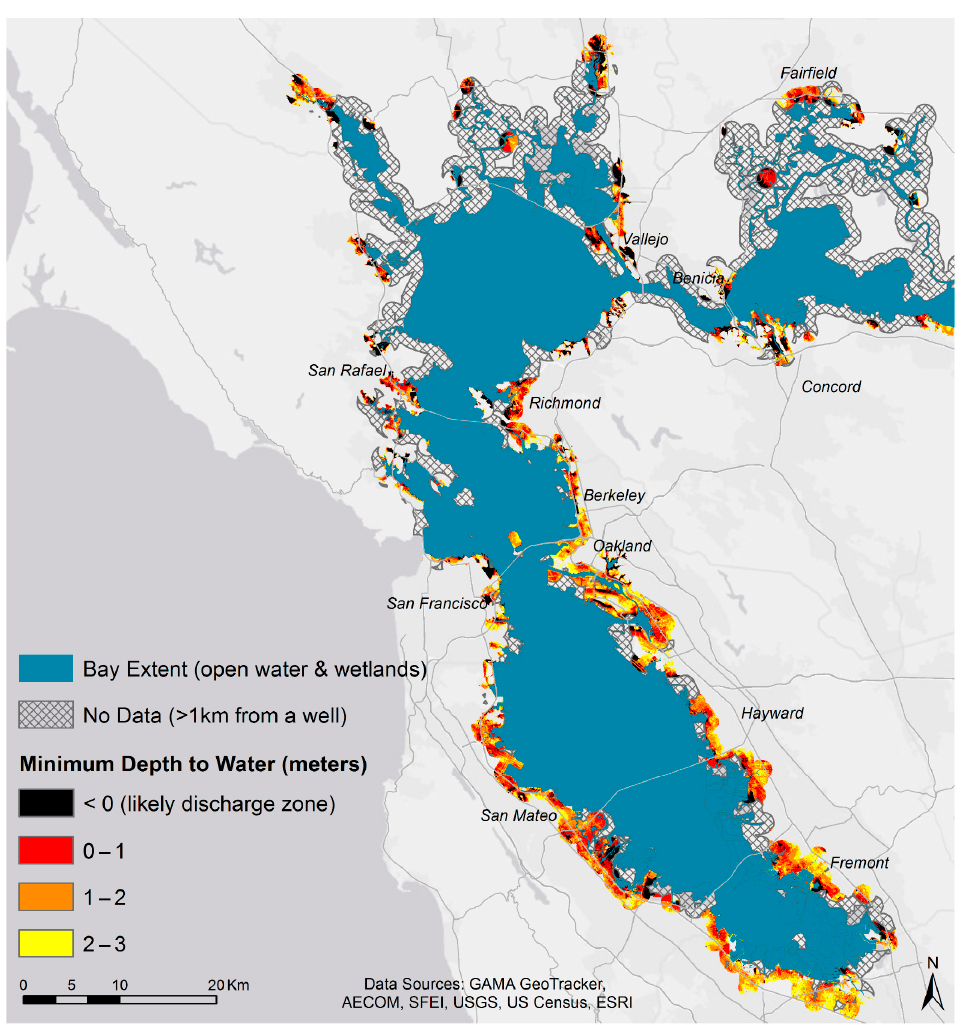
Figure 4. Minimum depth-to-water for the coastal San Francisco Bay Area. Shallow groundwater within one kilometer of the coast is shown in color, with the shallowest areas in red. Our method produced some negative values that suggested groundwater was already emergent, usually where there were no well points in the dataset at the base of a slope or in a valley. These areas (in black) most likely had very shallow groundwater with seasonal surface discharges, but a process-based model would be needed to quantify the